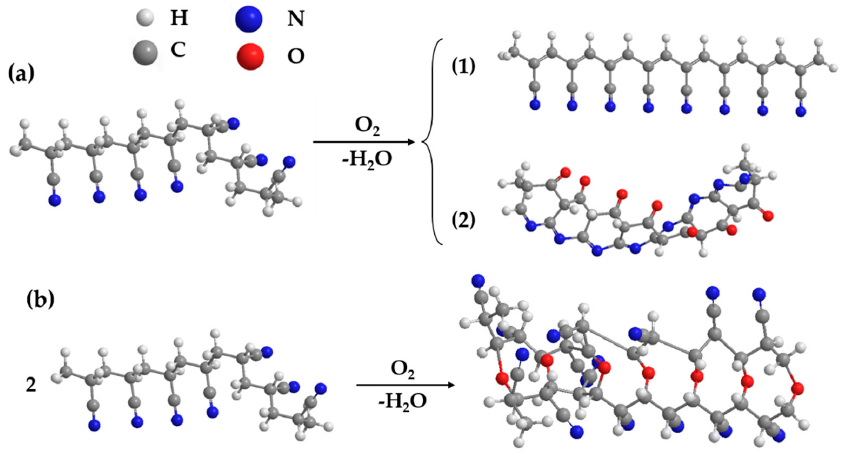
Figure 5. Cross-linking mechanism of PAN membrane ( a ) Intramolecular cyclization; ( b ) Intermolecular cross-linking.